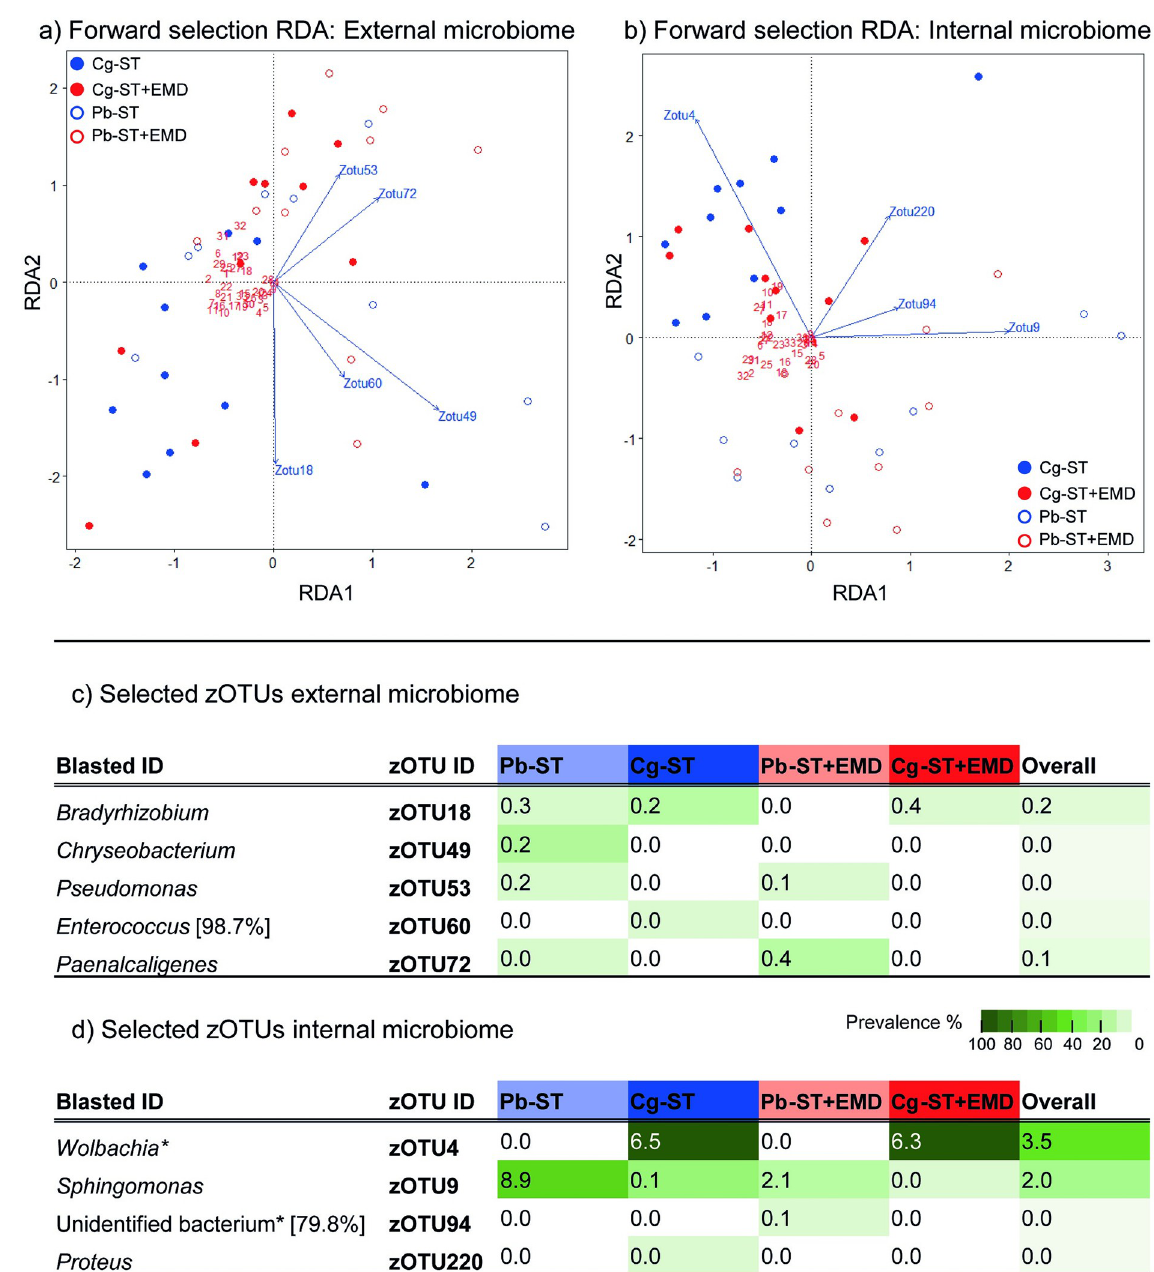
Fig 5. Forward selection redundancy analyses (RDA) on volatiles of untreated, starved or starved then external microbiome disrupted C . glomerata parasitised or unparasitised caterpillars ( P . brassicae ) and their bacterial communities. The triplots indicate the volatile composition of the caterpillars (dots), the volatile compounds (numbers as in Table 1) and forward selected zOTUs after 9999 permuations (vectors) for the external (a) and internal (b) bacterial communities. Further, relative abundance-prevalence data of the selected zOTUs are presented for the external (c) and internal (d) bacterial community. The average relative (%) abundance for each group is given in the cell as a percentage, whereas the colour indicates prevalence (white is absent). zOTUs were identified by a BLAST search against type materials in GenBank. When no significant similarity was found with type materials, the BLAST analysis was performed against entire GenBank (indicated with an asterisk). Identifications were performed at genus level. When identity percentages were lower than 99%, the percentage of sequence identity with the GenBank entry is given between brackets. Abbreviations used: Cg-ST = starved parasitised caterpillar; Cg-ST+EMD = starved then external microbiome disrupted parasitised caterpillars; Pb-ST = starved unparasitised caterpillars; Pb-ST+EMD = starved then external microbiome disrupted unparasitised caterpillars.